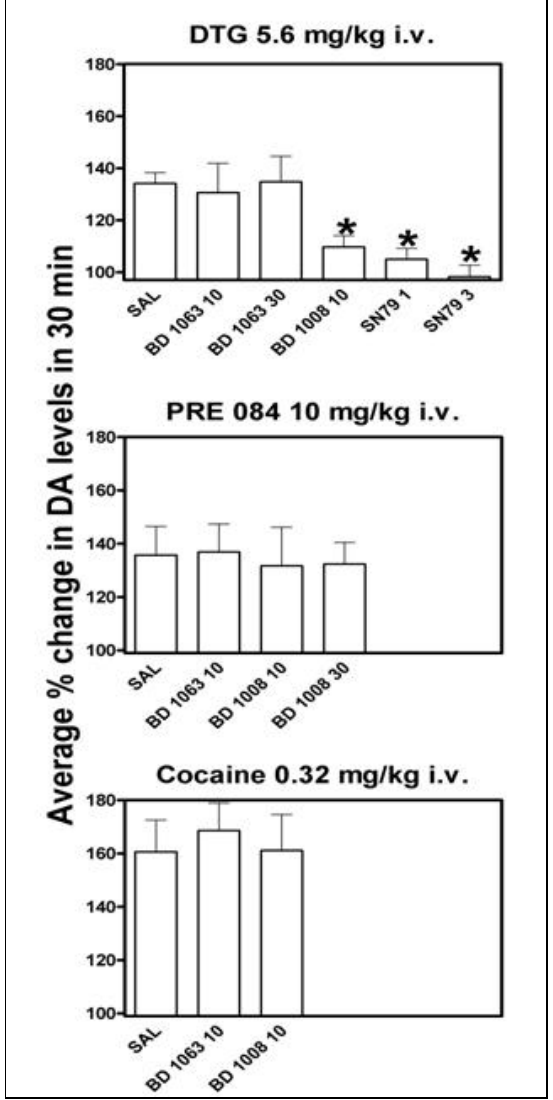
Figure 3. Effects of pretreatments with selective σ R antagonists on DTG-, PRE-084-, and cocaine-induced stimulation of DA levels in dialysates from the NAC shell in